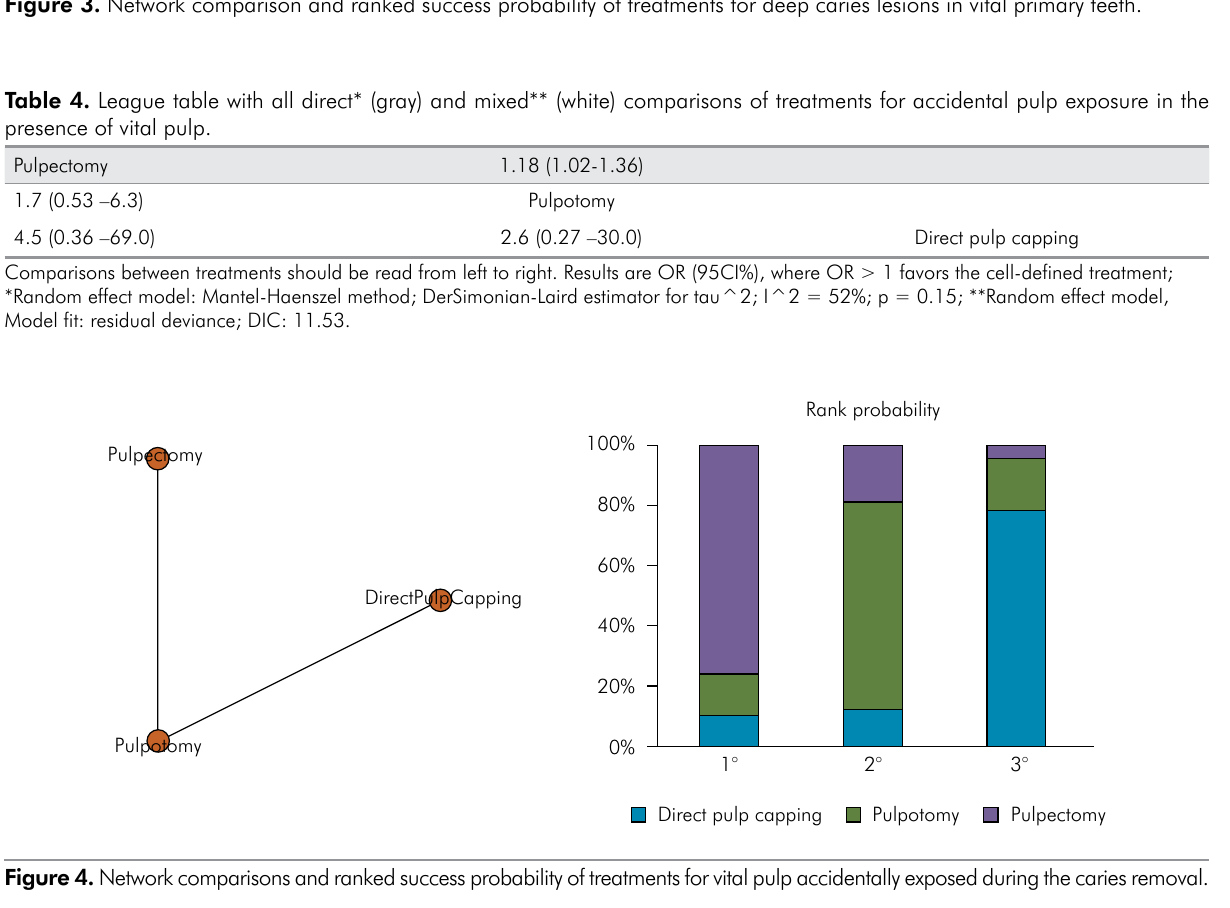
Figure 3. Network comparison and ranked success probability of treatments for deep caries lesions in vital primary teeth.